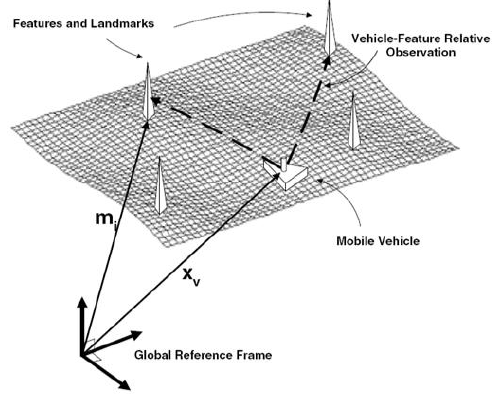
Figure 4. A robot measuring relative observations to environmental landmarks.